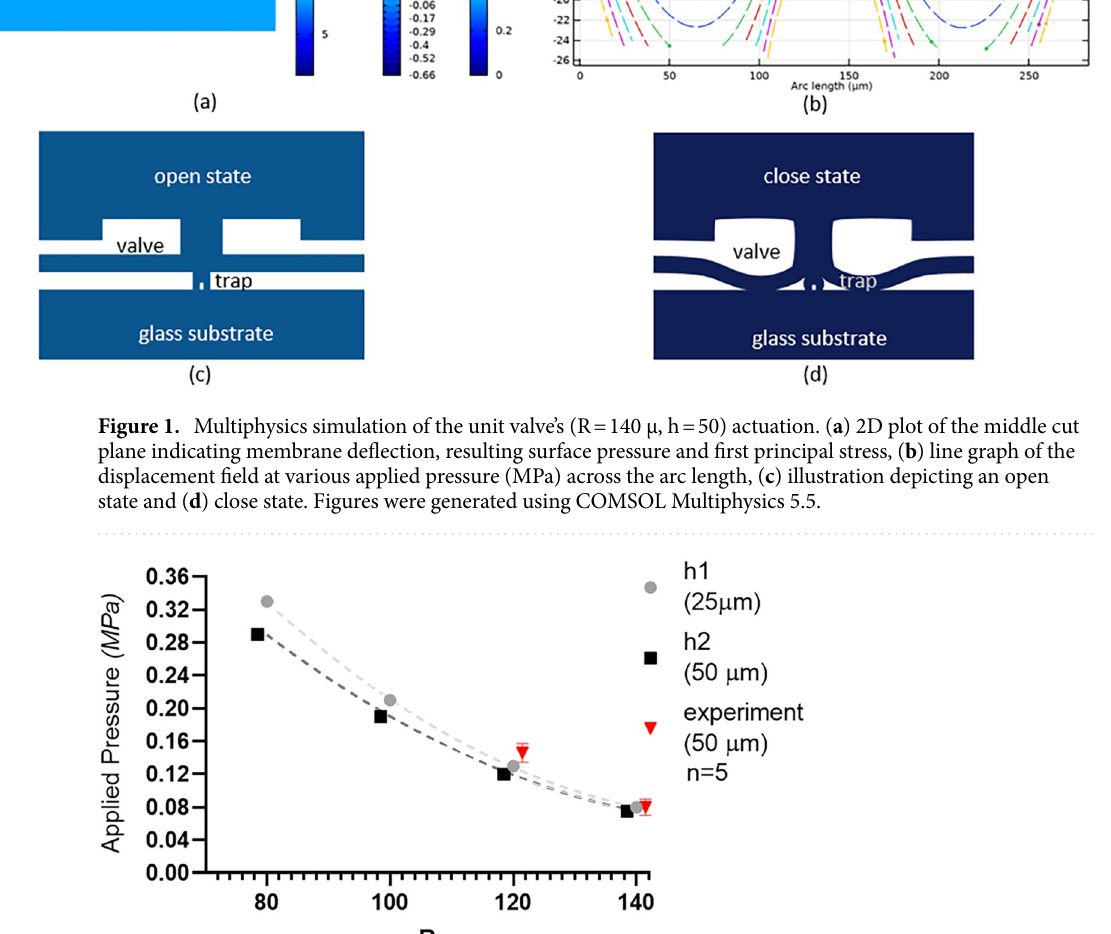
Figure 2. Relationship of the valve radius R and height h to the sealing pressure. Graph created using GraphPad Prism